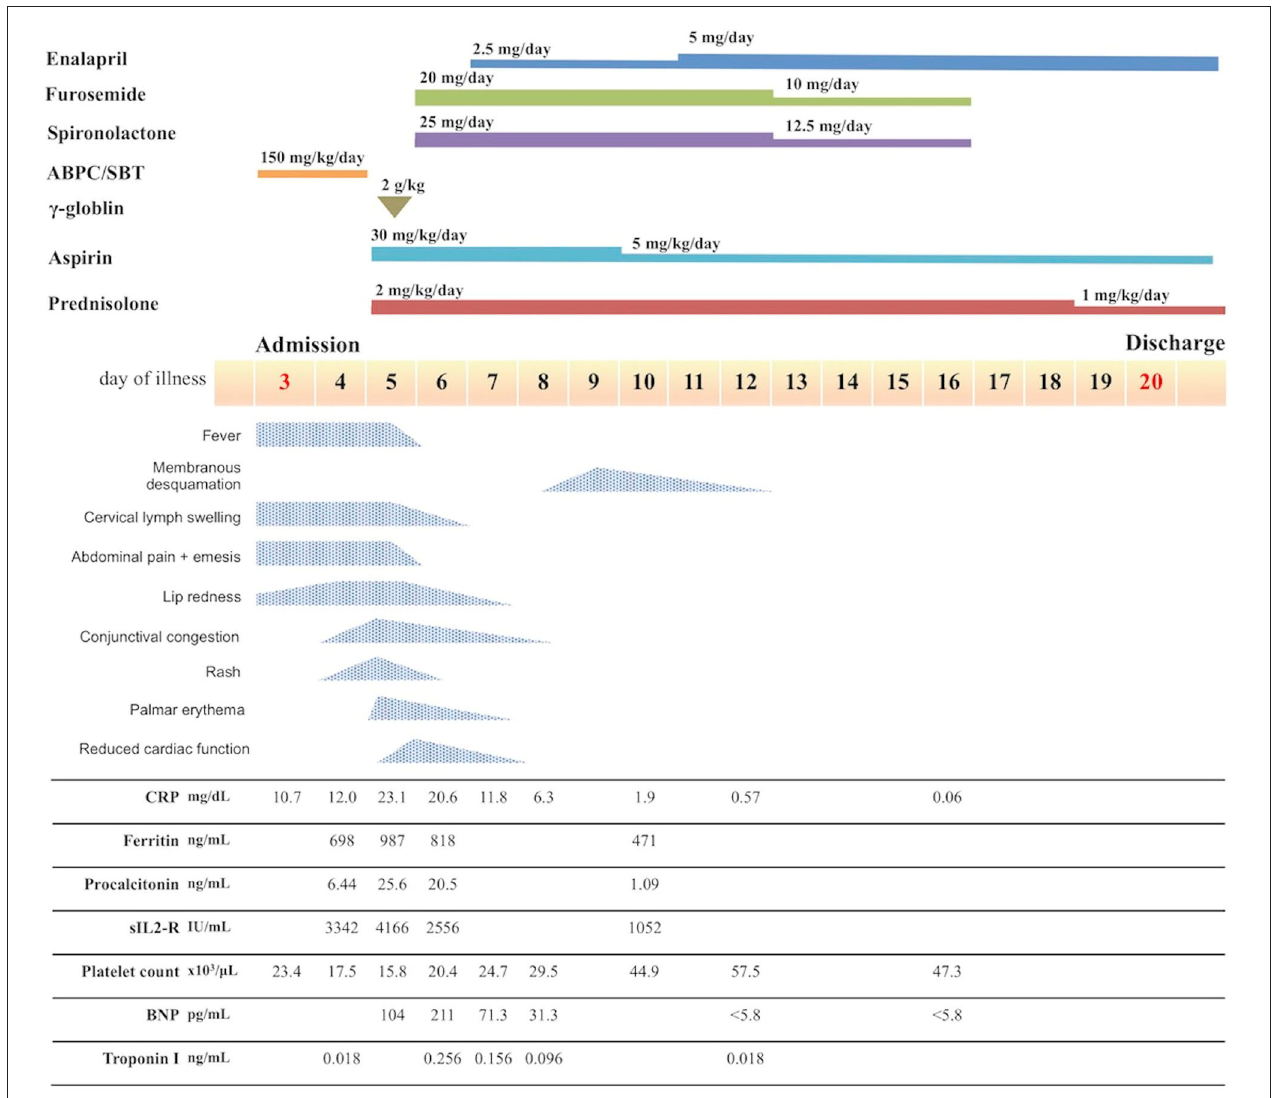
FIGURE 1 | Course of disease after admission. ABPC/SBT, ampicillin/sulbactam; CRP, C-reactive protein; sIL2-R, soluble interleukin-2 receptor; BNP, B-type natriuretic peptide.